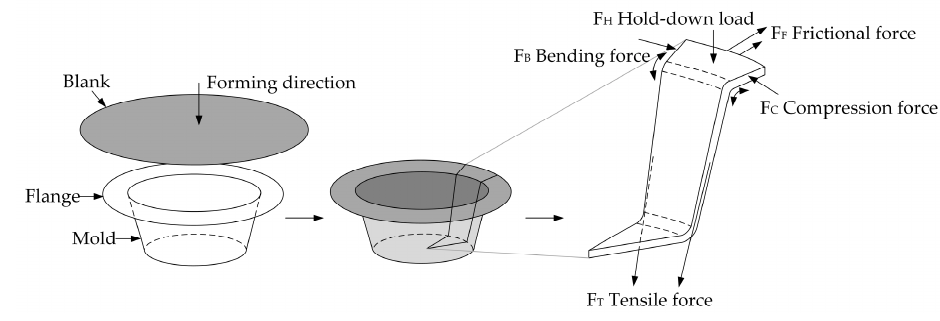
Figure 6. Force analysis in 3D stamp forming, modified from [44].